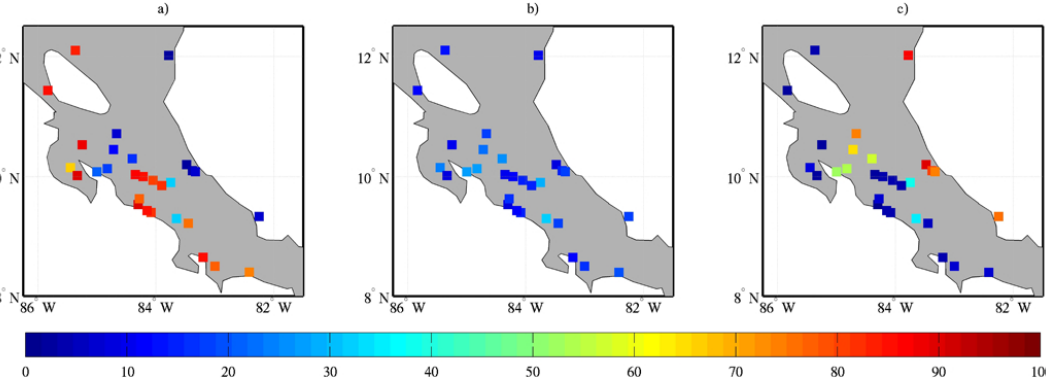
Fig. 10. CCA precipitation forecasts for ASO 2010 frequency of rainy days (FRD) using July SST as predictor. Forecast probability maps are for categories (a) Above, (b) Normal, (c) Below.